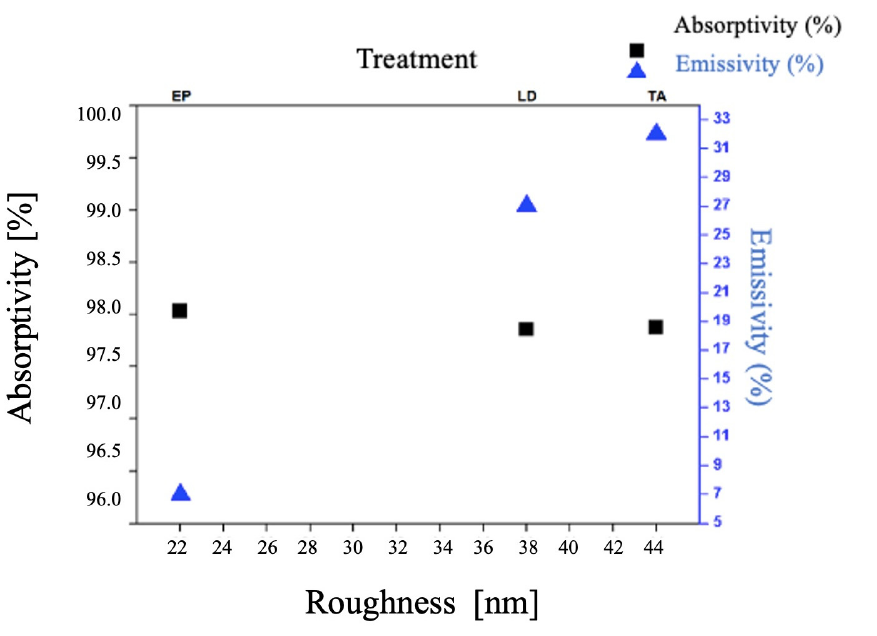
Figure 8. Coatings’ roughness, absorptivity, and emissivity according to treatments and 1 min of deposition time (DC-Detergent cleaning, AT-Acid treatment, EP-Electropolishing).